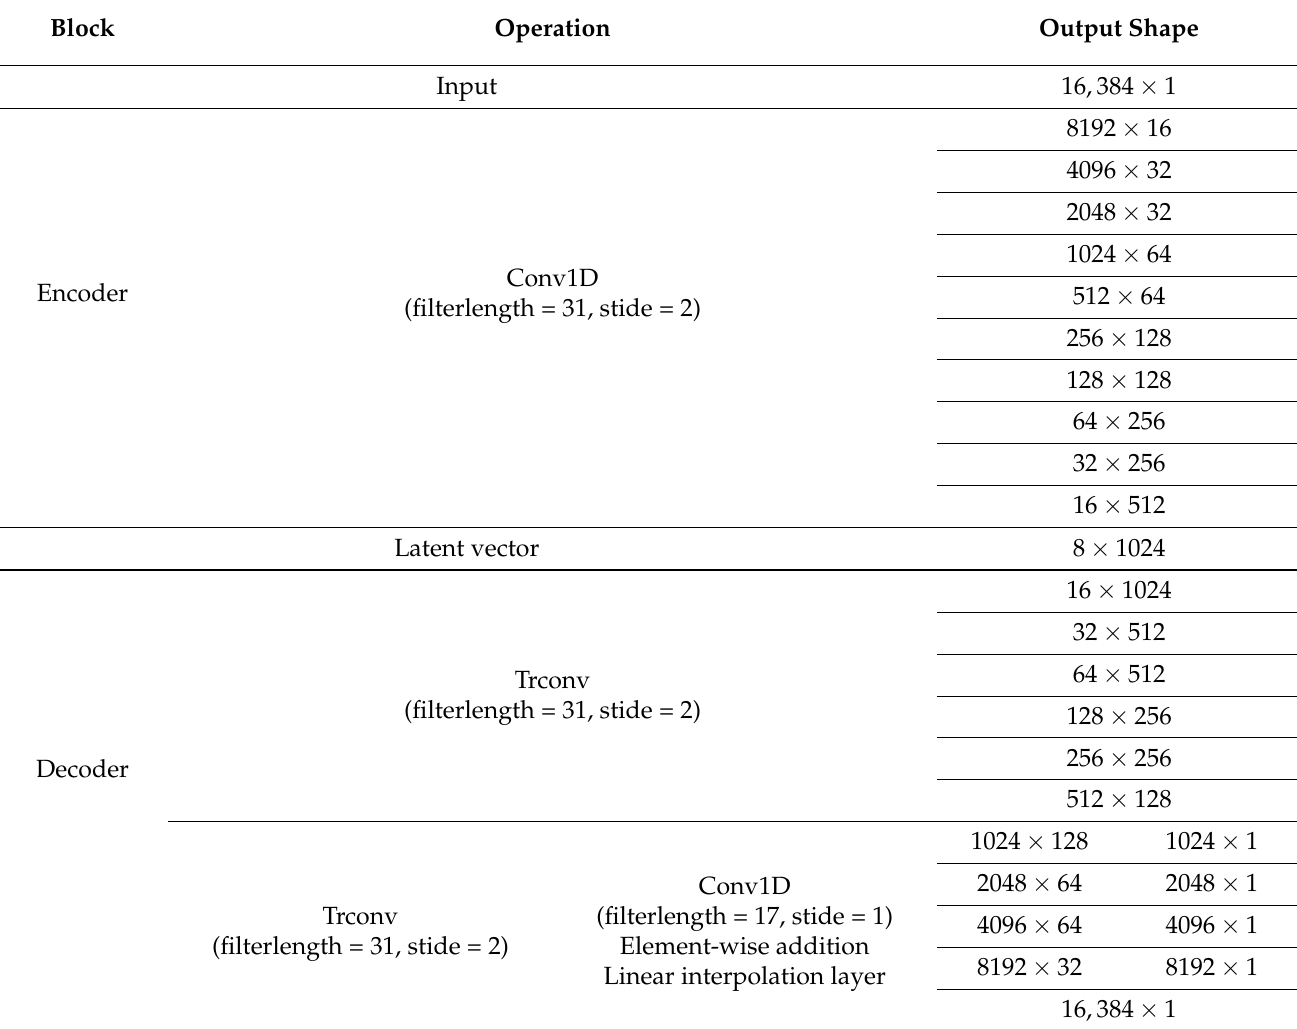
Table 1. Architecture of the proposed generator. Output shape represented temporal dimension and feature maps. Block